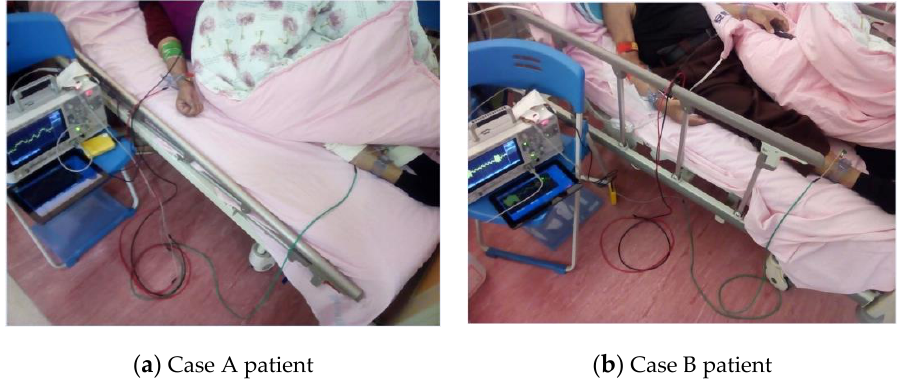
Figure 10. Hemodialysis while observing the extent of heart rate variability affecting sympathetic and parasympathetic